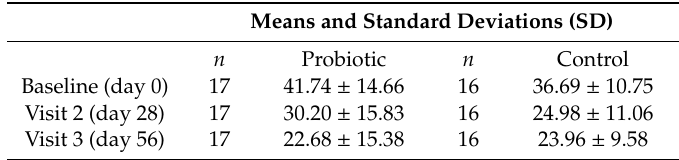
Table A2. SCORing Atopic Dermatitis (SCORAD) index of the subjects after continuous use of the probiotic or control product at baseline, visit 2 (day 28) and visit 3 (day 56). Standard deviation (SD).